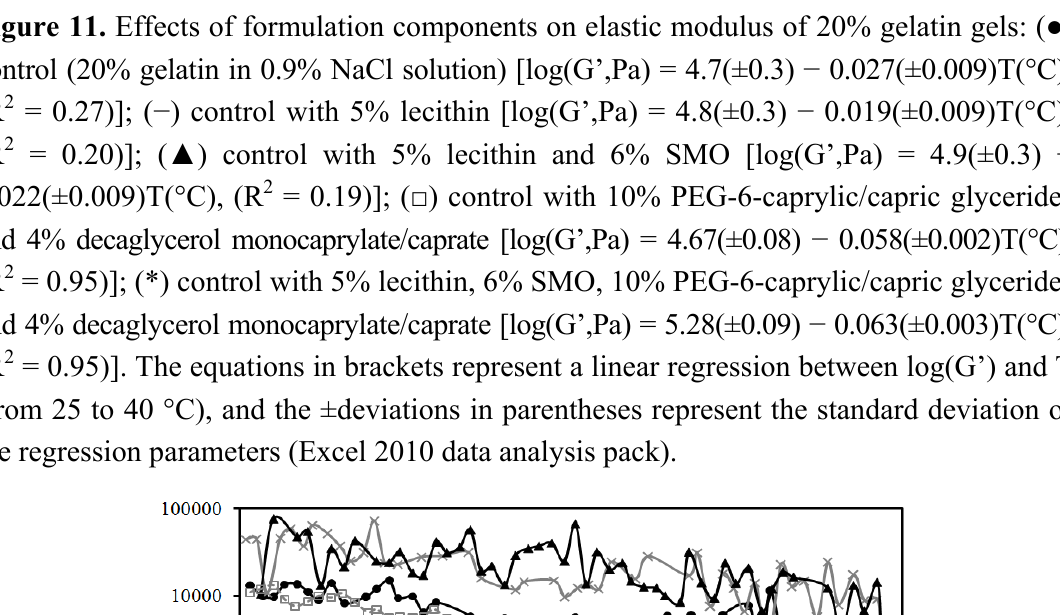
Figure 11. Effects of formulation components on elastic modulus of 20% gelatin gels: ( ●